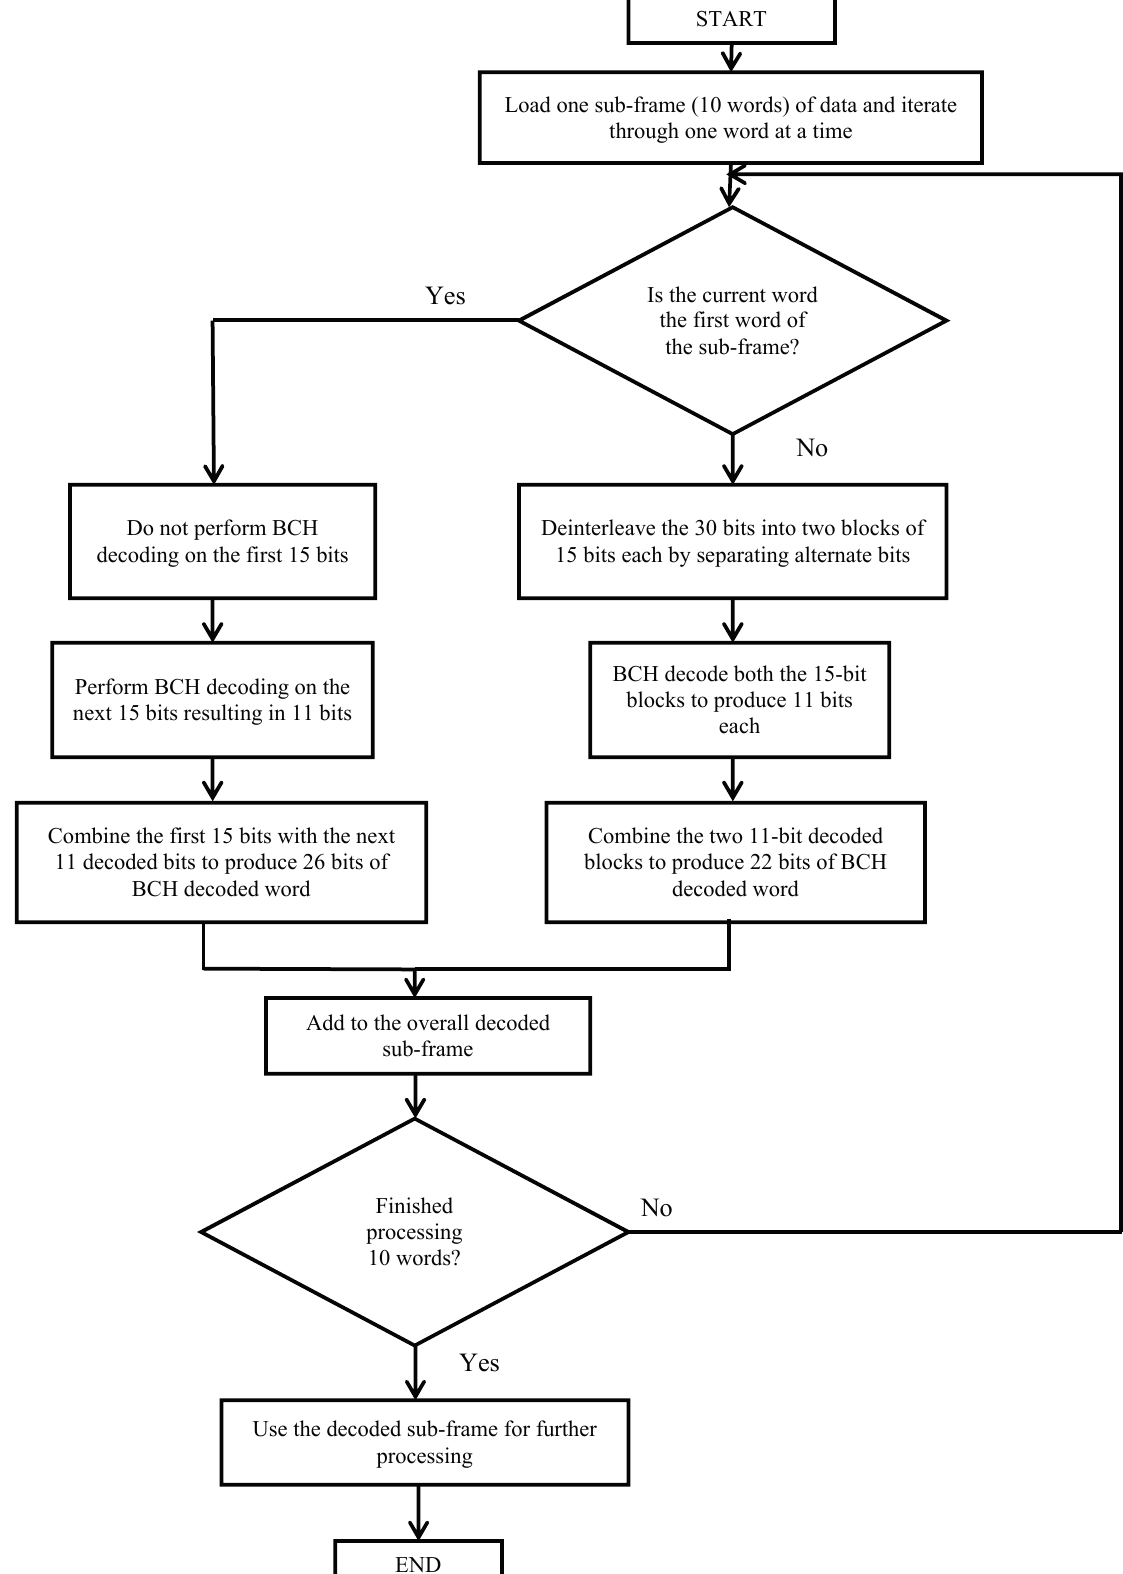
Figure 7. Flowchart illustrating the decoding procedure of BeiDou navigation